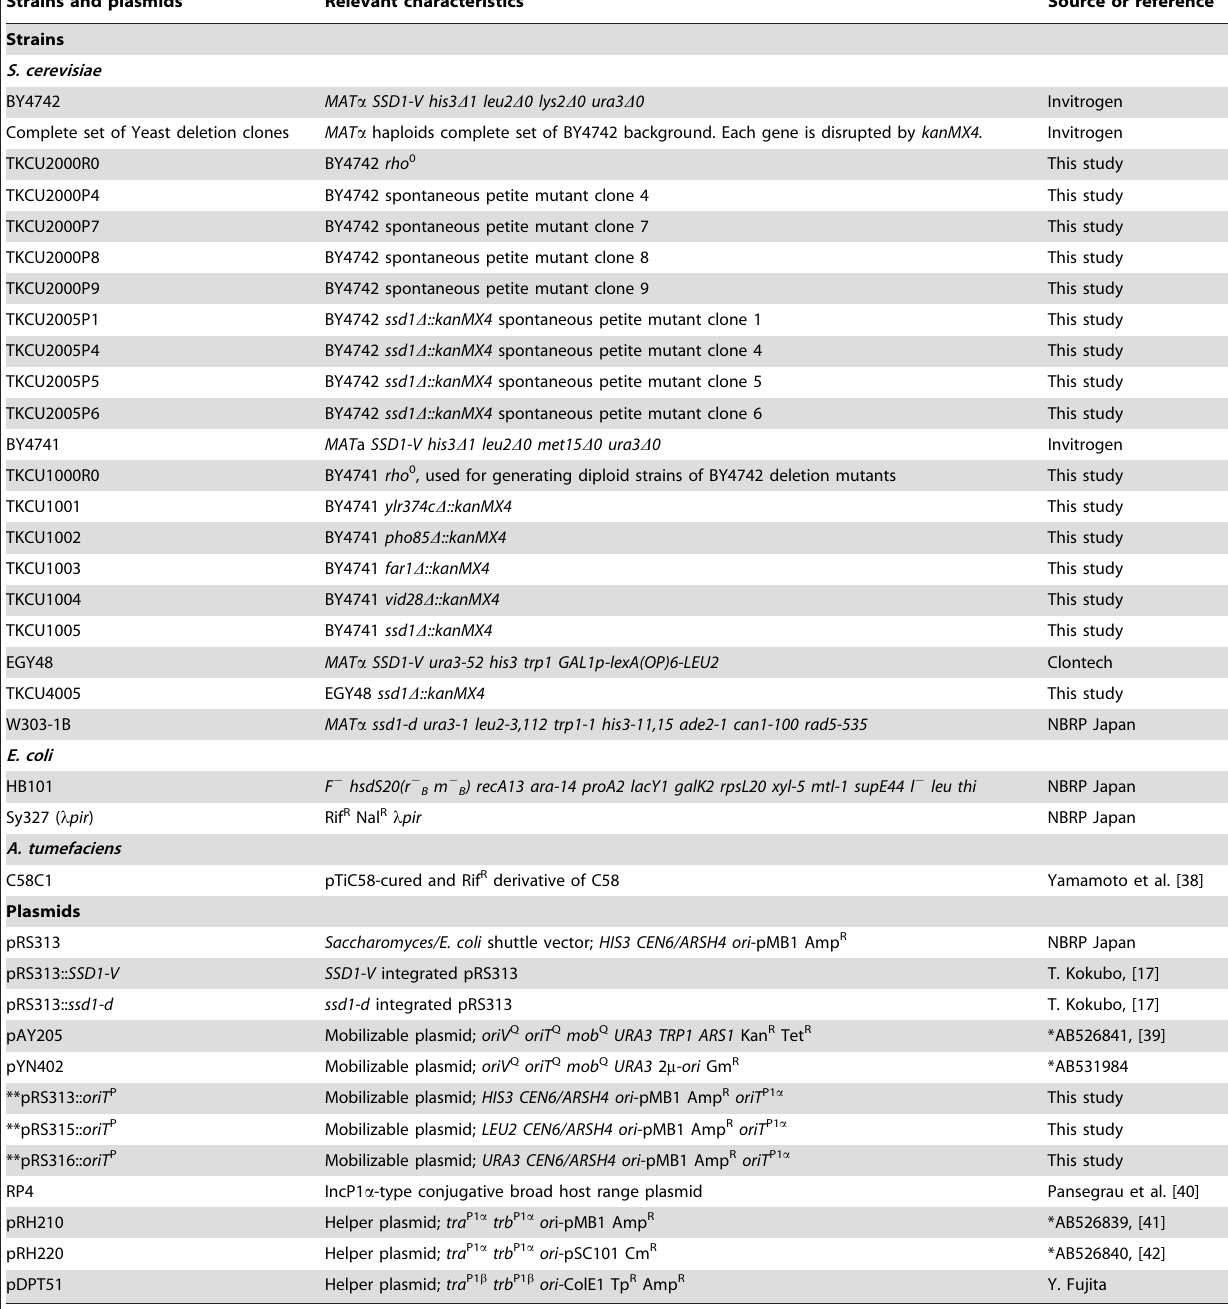
Table 1. Strains and plasmids used in this